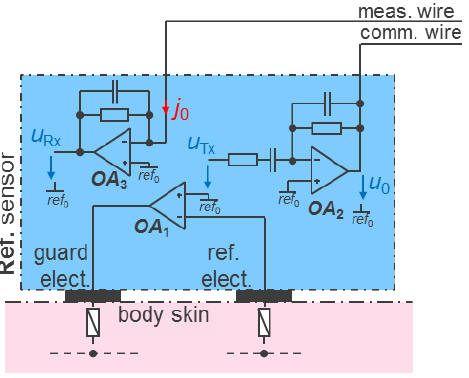
Figure 7. Detailed electronics of the reference sensor